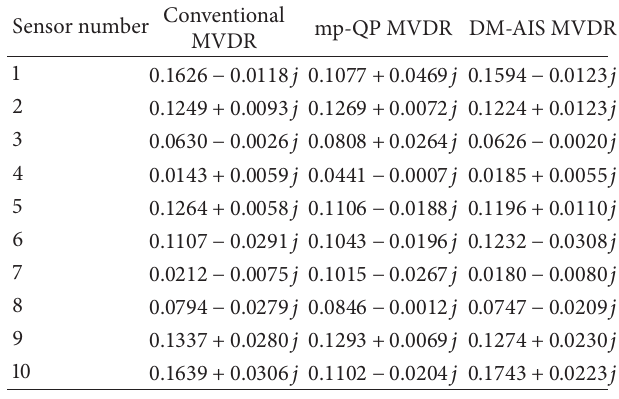
Table 4: Weight vector values of conventional MVDR, mp-QP MVDR, and DM-AIS.